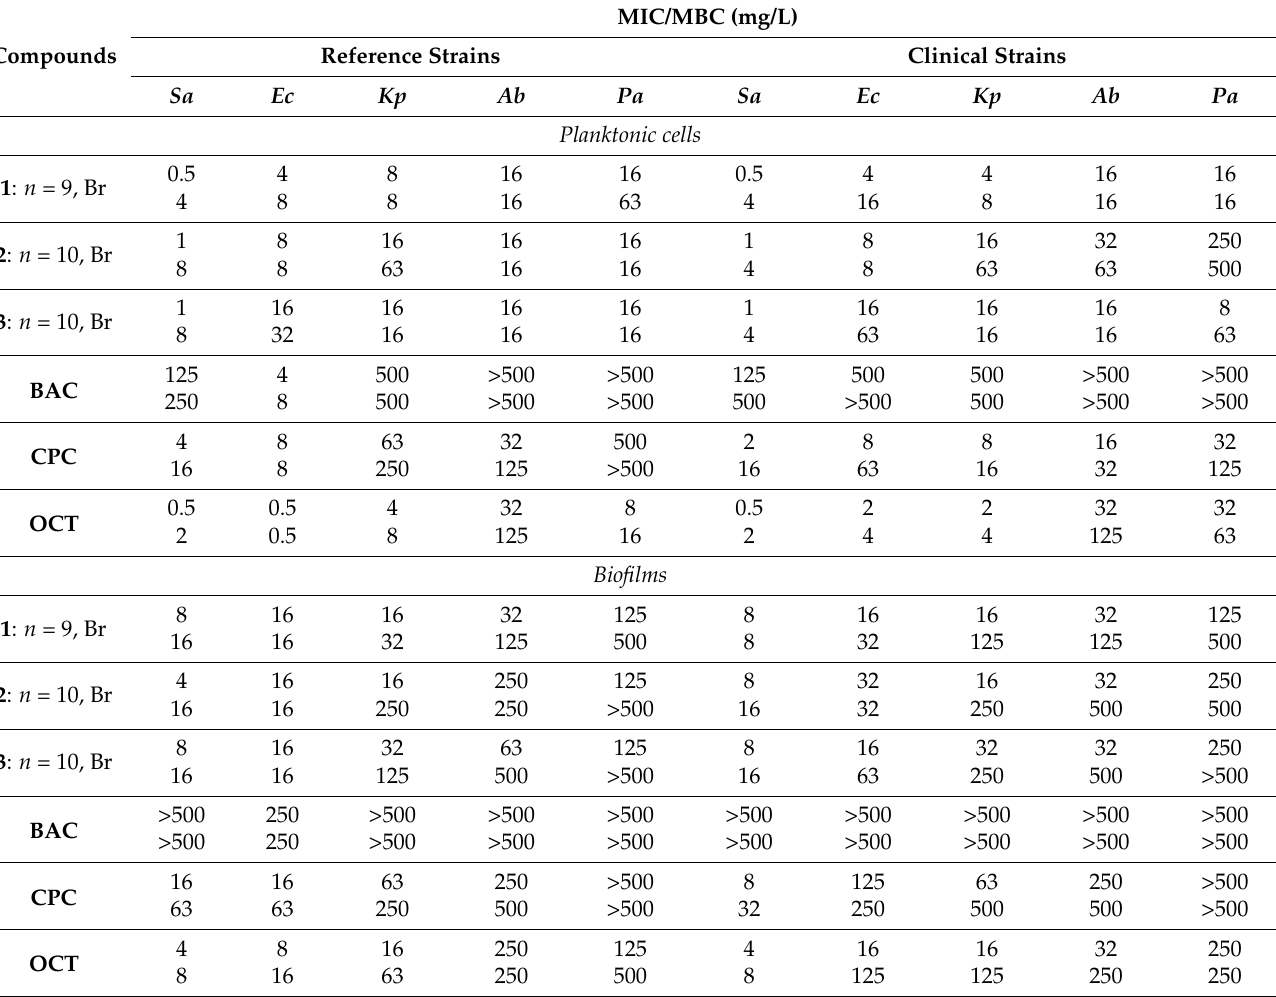
Table 3. Antibacterial activity of new bis-QACs against planktonic cells and